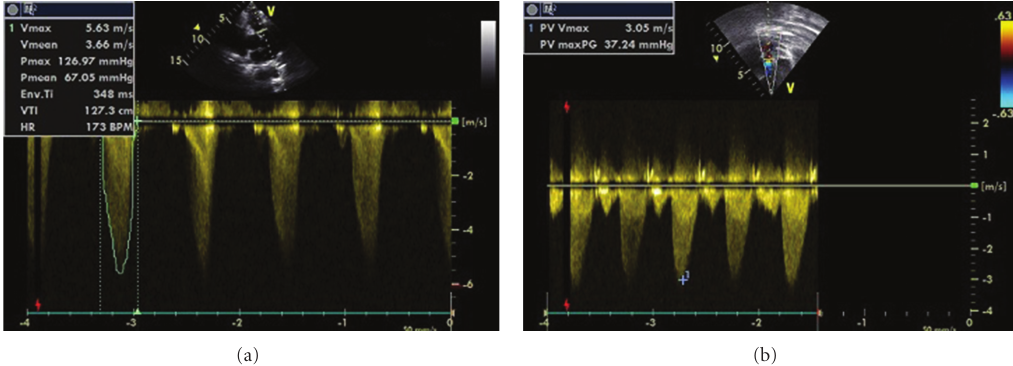
Figure 1: The figure shows pulmonary valve stenosis with a maximum gradient of 126 mmHg before pulmonary balloon valvuloplasty (a) and mild pulmonary valve stenosis with a maximum gradient of 37 mmHg after pulmonary balloon valvuloplasty